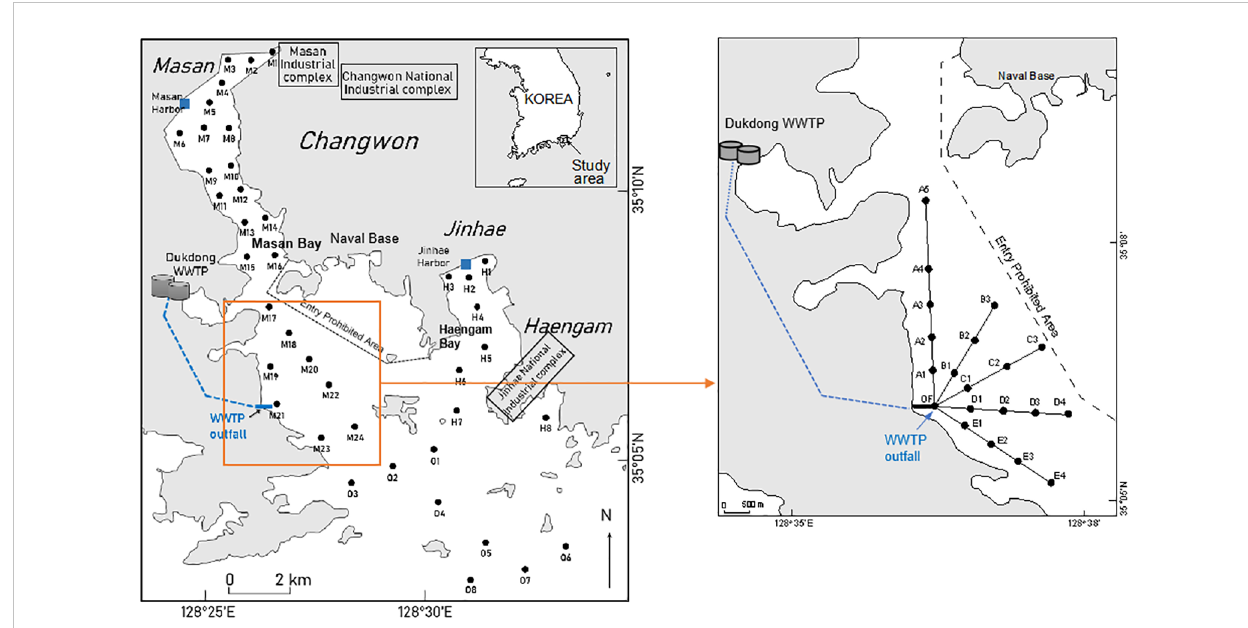
FIGURE 1 Sampling locations of sediment from Masan and Haengam Bays of Korea and around the submarine outfall of a wastewater treatment plant (enlarged map) collected in 2013 and